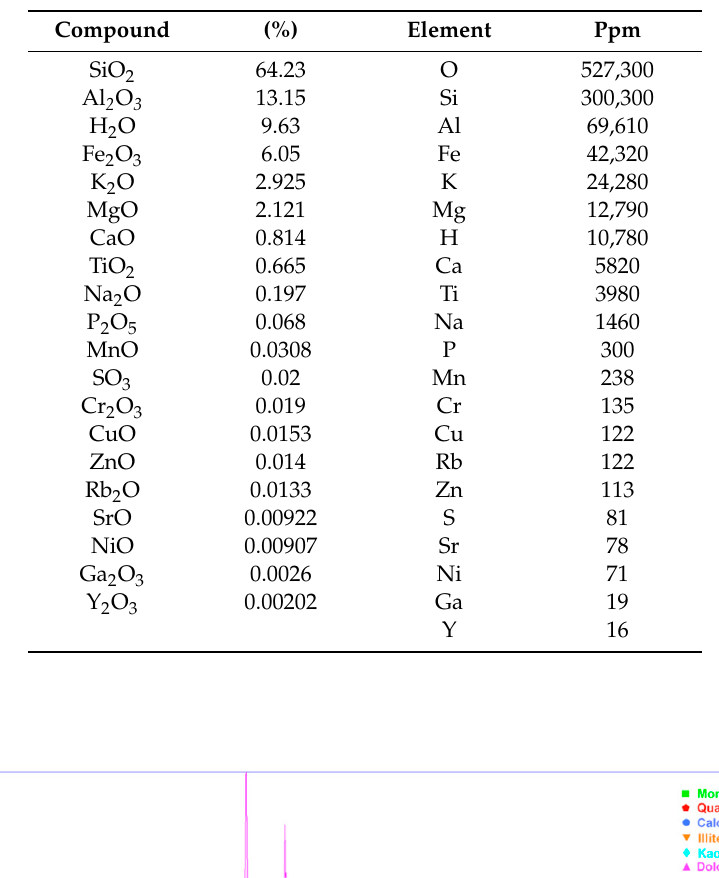
Table 2. Concentrations (in % and ppm) of the major and minor elements identified in the XRF analysis. The table represents mean values on XRF tests that have been performed on seven samples.